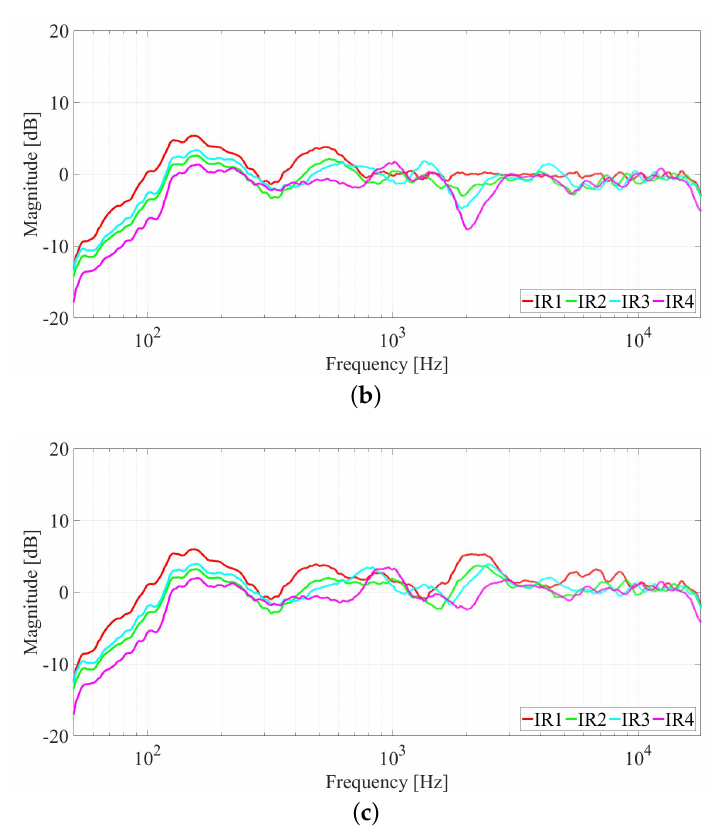
Figure 8. Equalization procedure: ( a ) impulse responses (IRs) with prototype function H prot , multi-point equalizer EQ multi , single-point equalizer EQ single . Equalization results applying ( b ) single-point equalizer EQ single ; and ( c ) multi-point equalizer EQ multi